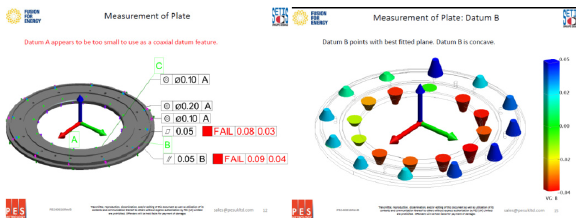
Fig. 11. Reference plane on the SC magnet top plate (AGP) and plate deformations measured by laser tracker.